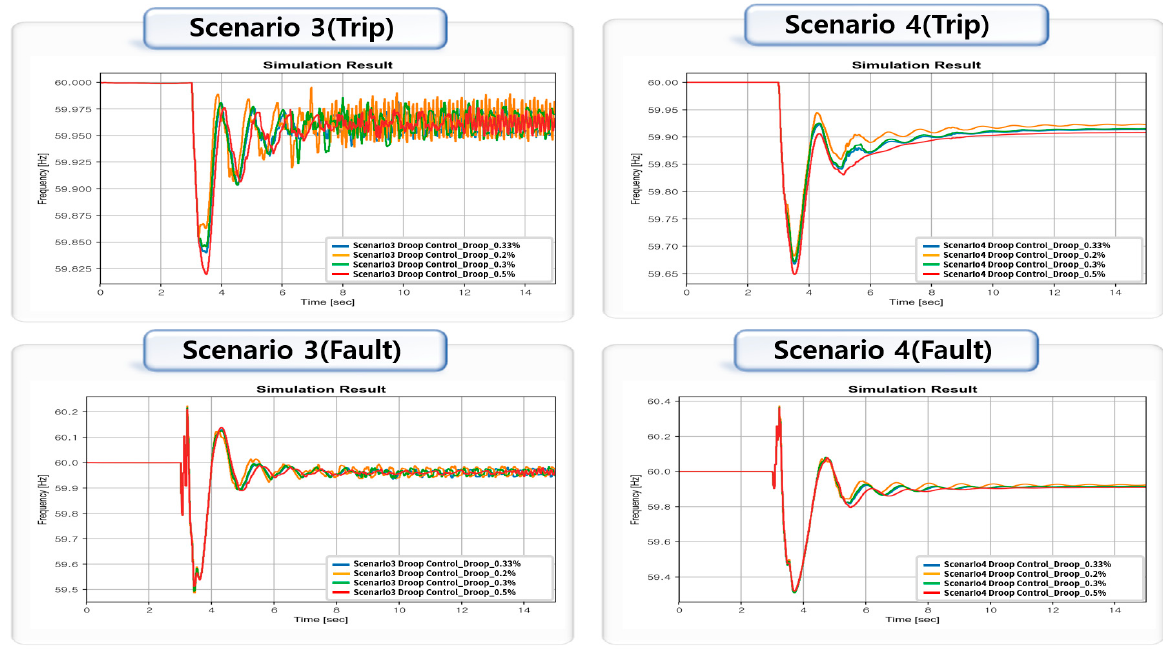
Figure 14. Frequency response by ESS parameter (droop control).